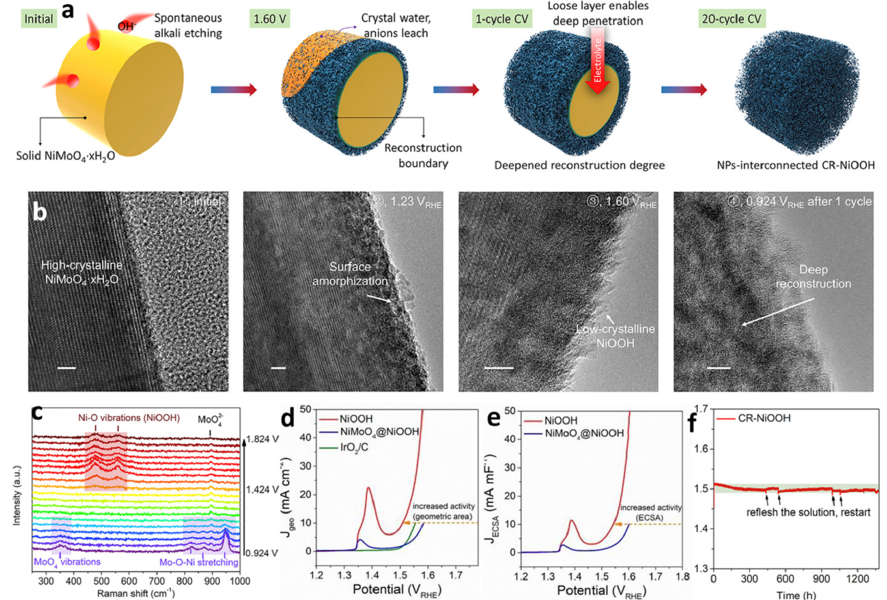
Figure 8. ( a ) Schematic diagrams of the complete surface change process for NiMoO 4 . xH 2 O. ( b ) Ex situ HRTEM images of the different reconstruction degrees at various activated stages of NiMoO 4. xH 2 O. Scale bars, 5 nm. ( c ) In situ Raman spectra of NiMoO 4. xH 2 O during the OER process. LSV curves of the studied catalysts for the OER normalized by the ( d ) geometric area and ( e ) electrochemically active surface area. ( f ) Ultra-long stability test of the completely reconstructed NiOOH at a current density of 10 mA cm − 2 . Reproduced with permission [85]. Copyright 2020, Cell Press.